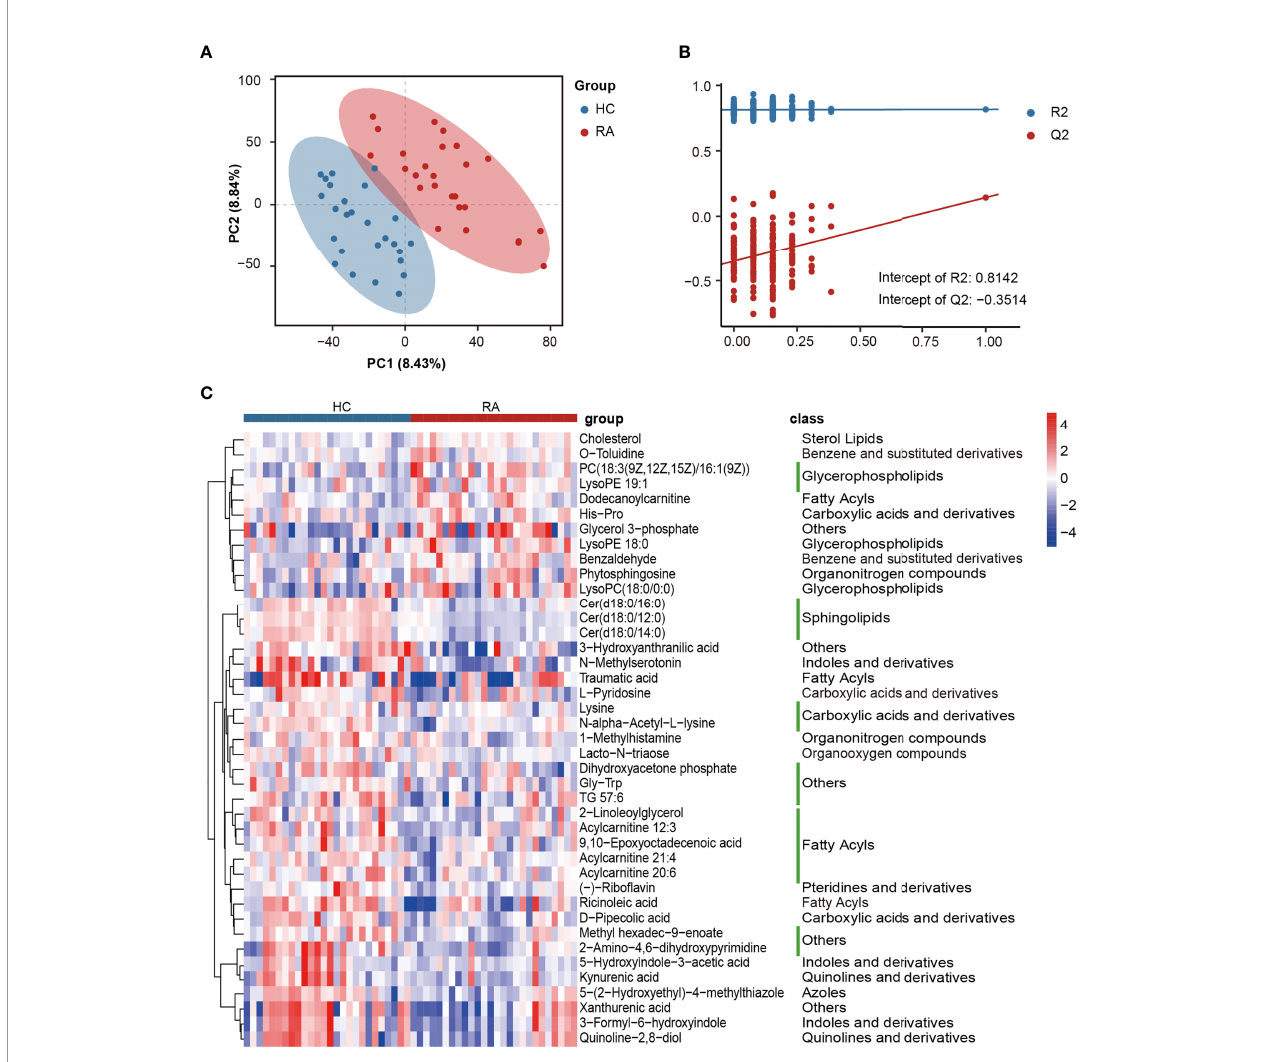
FIGURE 4 | The alterations in fecal metabolites of RA patients. (A) PLS-DA score plot of the fi rst two principal components. (B) Validation model through 200 permutation tests. (C) The heat map of differentially abundant metabolites based on the relative